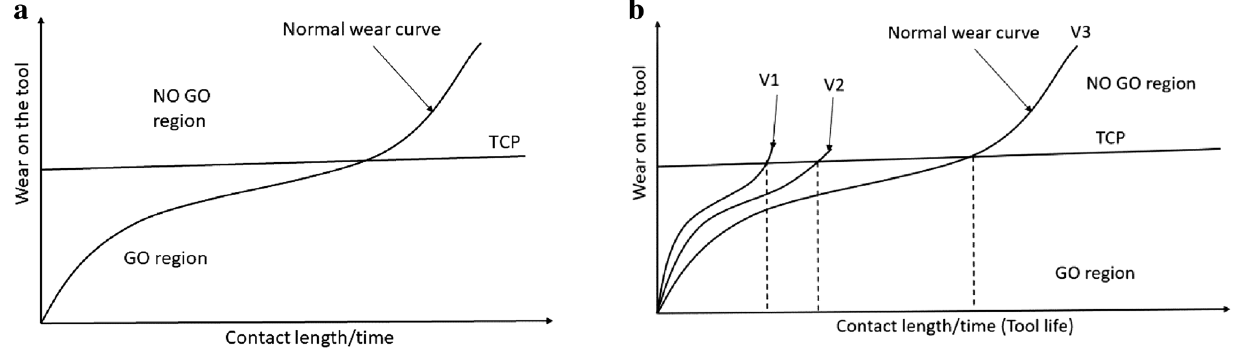
Fig. 3 a Graphic illustration of normal wear curve for cutting tool with GO/ NO GO regions overlapped b Graphic illustration of wear curve for different cutting speeds and realtive change in TCP (adapted from